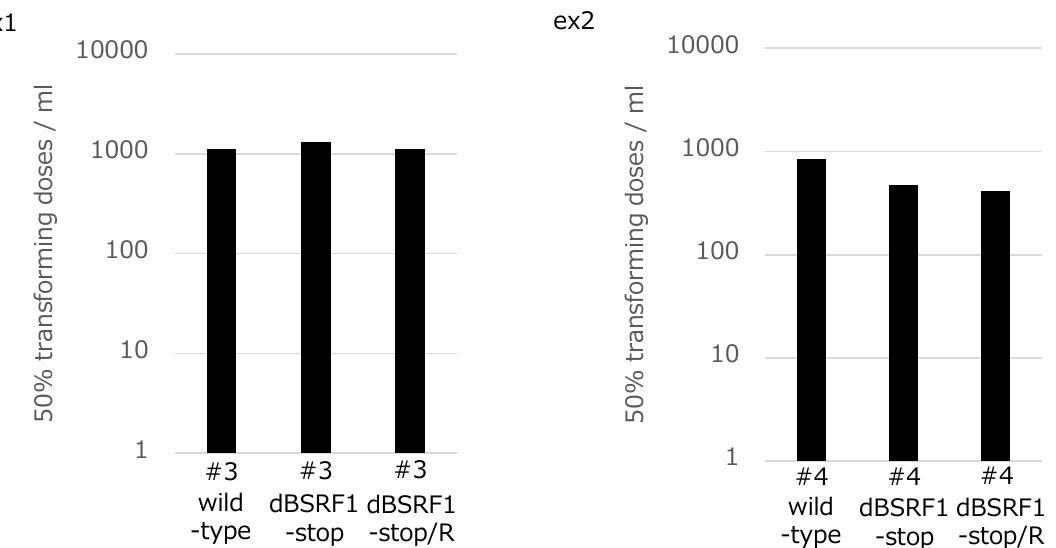
Figure 3. Transformation efficiency of BSRF1 KO mutant virus. Viruses in culture medium of HEK293 EBV-BAC cells were prepared and the titers were determined using Akata( − ) cells. After normalization of the titers, 10-fold serial dilutions were prepared and used to separately infect peripheral blood mononuclear cells (PBMCs) from two healthy donors ( ex1 and ex2 ). Bars indicate 50% TU/mL values. Cell-clone numbers are also shown (#3, #4).